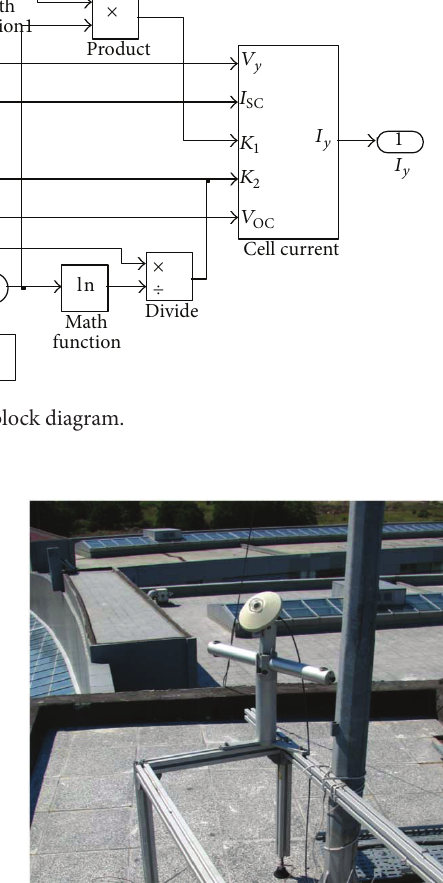
Figure 5: Measurement setup of incident global radiation on the